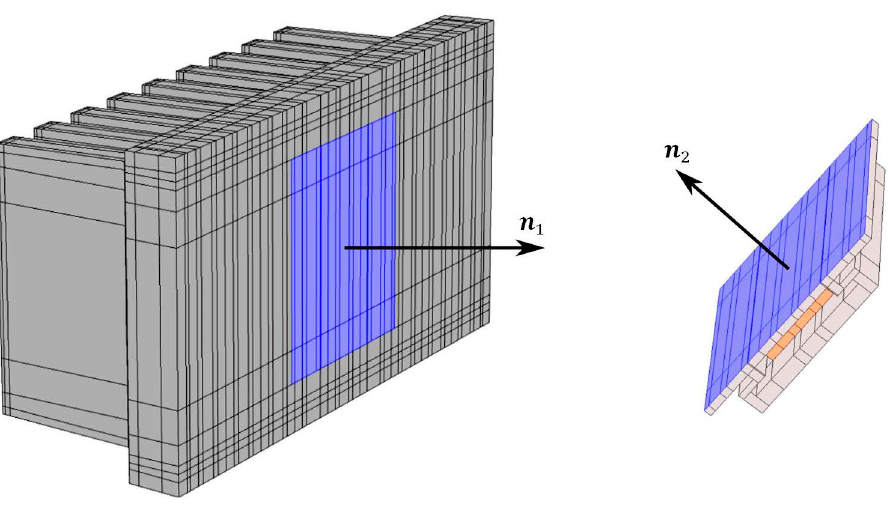
Figure 10. Thermal contact applied on the contact surfaces between the heat sink and the heater.